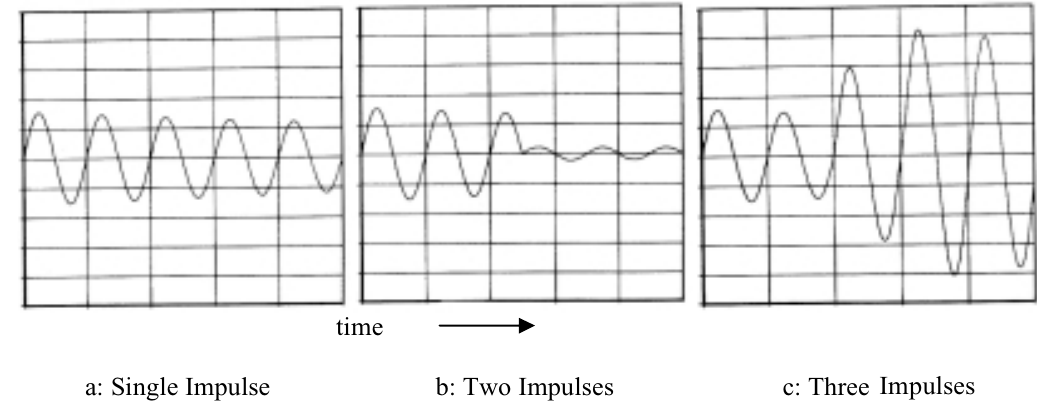
Fig. 7. Response of simple spring-mass system to 1, 2, and 3